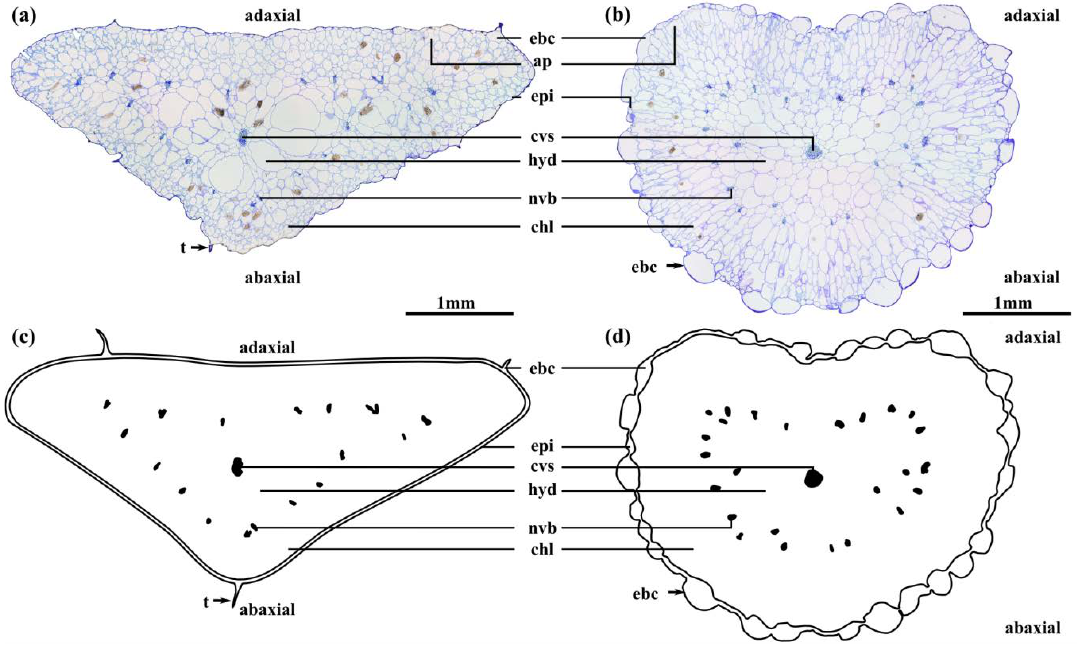
Figure 2. Comparison of transverse sections of the leaves of D. ecklonis ( a ) and D. cooperi ( b ). ( a ) Light microscopic image of the transverse section of a triquetrous D. ecklonis leaf. Large hydrenchyma cells (hyd) surround the central vascular strand (cvs) and can be clearly distinguished from the smaller chloroplast-rich chlorenchyma tissue (chl). Trichomes (t) show bladder-like enlargements at the leaf surface. ( b ) Light microscopic image of a transverse section of a terete D. cooperi leaf with slightly canaliculated adaxial and convex abaxial sides. Schematic drawings of a transverse section of leaves of D. ecklonis ( c ) and D. cooperi ( d ) highlighting the various tissue layers. ap: air pockets; chl: chlorenchyma; cvs: central vascular strand; ebc: epidermal bladder cell; epi: epidermis; hyd: hydrenchyma; nvb: peripheral net of vascular bundles; t: trichome.